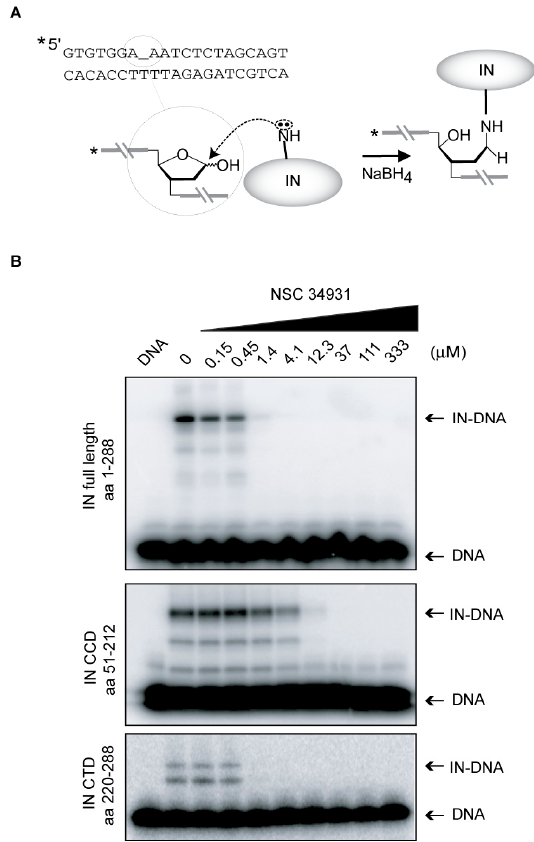
Figure 5. Inhibition of IN-DNA binding by NSC34931. ( A ) Principle of the Schiff base crosslinking assay. An abasic site was introduced by uracil DNA glycosylase in the DNA substrate at the -12 position. An IN nitrogen nucleophile (probably lysine) attacks the C1 ′ -carbon of the abasic site. Rearrangement of the initial enzyme–DNA complex leads to the formation of a Schiff base intermediate that can be stabilized by reduction via NaBH 4 . The asterisk indicates the 5 ′ -[ 32 P]-label. ( B ) Representative SDS-PAGE image showing the inhibition by NSC34931 of crosslinking between IN and DNA using full-length IN (1–288), the isolated catalytic core domain (CCD) (51–212), or the isolated C -terminal domain (CTD) (220–288).